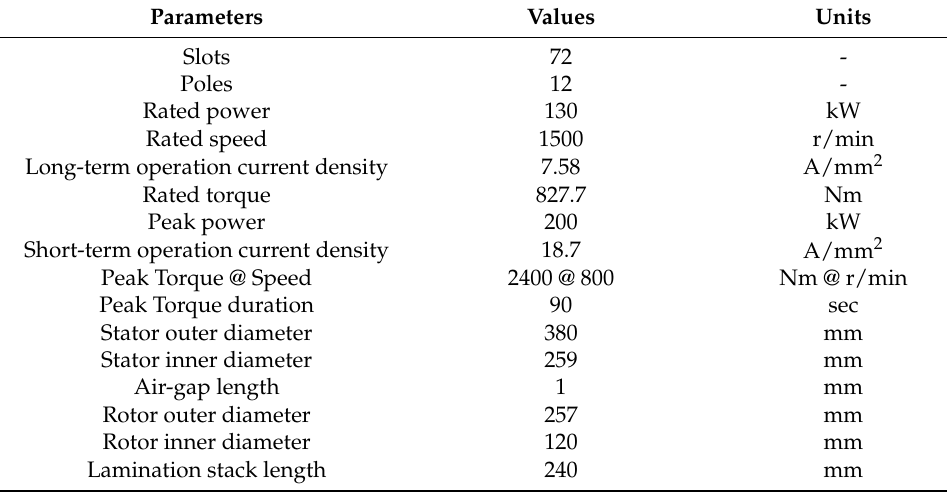
Figure 1. The 200 kW PMSM structure. ( a ) 2D Cross Section. ( b ) 3D structure. Table 1. Basic parameters of a 200 kW PMSM.